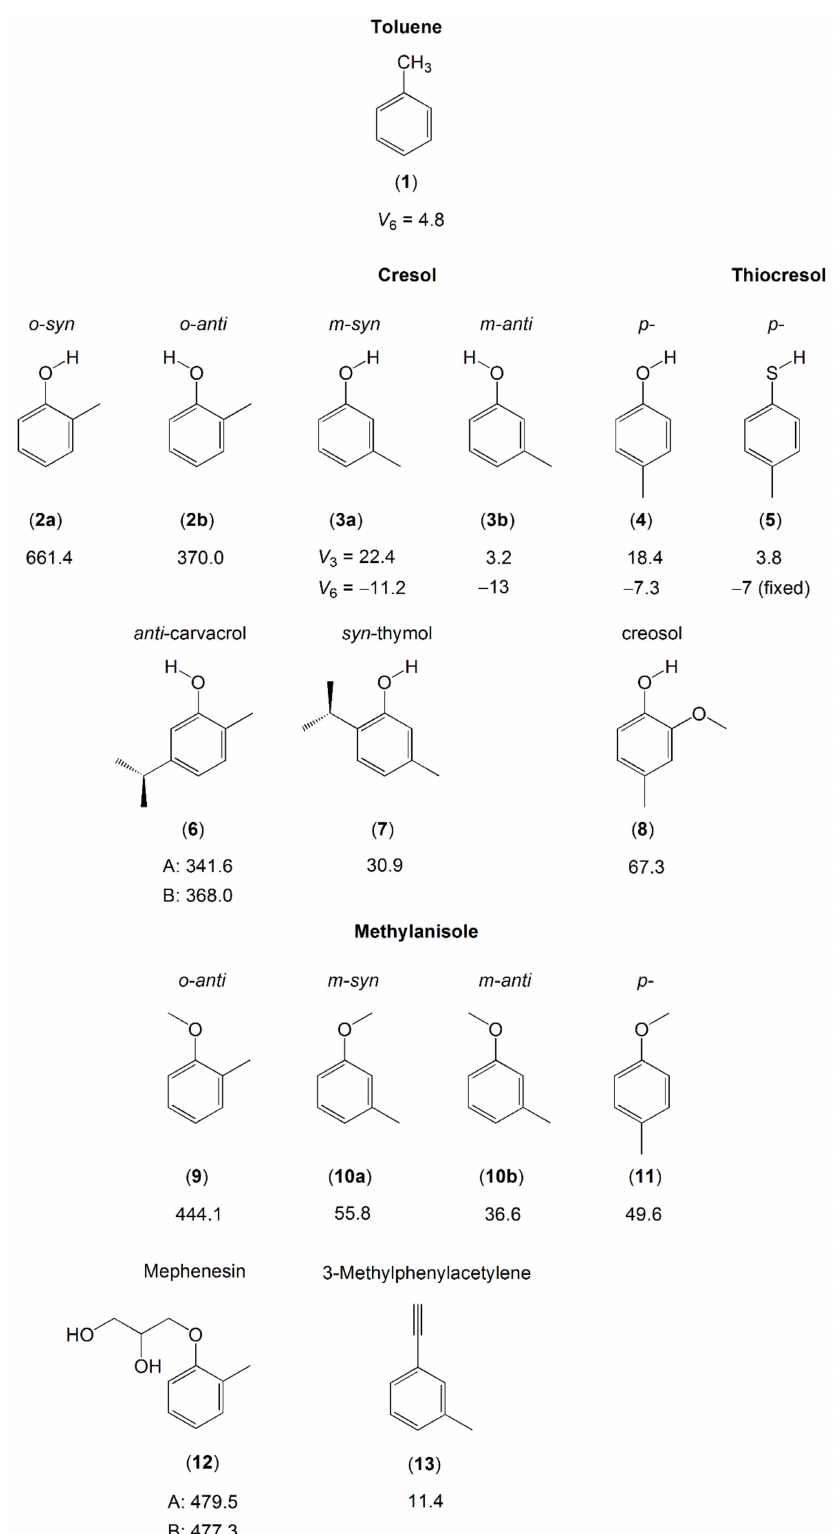
Figure 5. Barriers to methyl internal rotation in toluene and cresol derivatives (in cm − 1 ). ( 1 ) The pro- totype toluene [137–142], ( 2 ) o-cresol [143], ( 3 ) m-cresol [144], ( 4 ) p-cresol [145], ( 5 ) p-thiocresol [146], ( 6 ) anti-carvacrol (two conformers, A and B) [147], ( 7 ) syn-thymol [147], ( 8 ) creosol [148], ( 9 ) o-methyl anisole [127], ( 10 ) m-methyl anisole [149,150], ( 11 ) p-methylanisole [151], ( 12 ) mephenesin (two conformers, A and B) [152], ( 13 ) 3-methylphenylacetylene